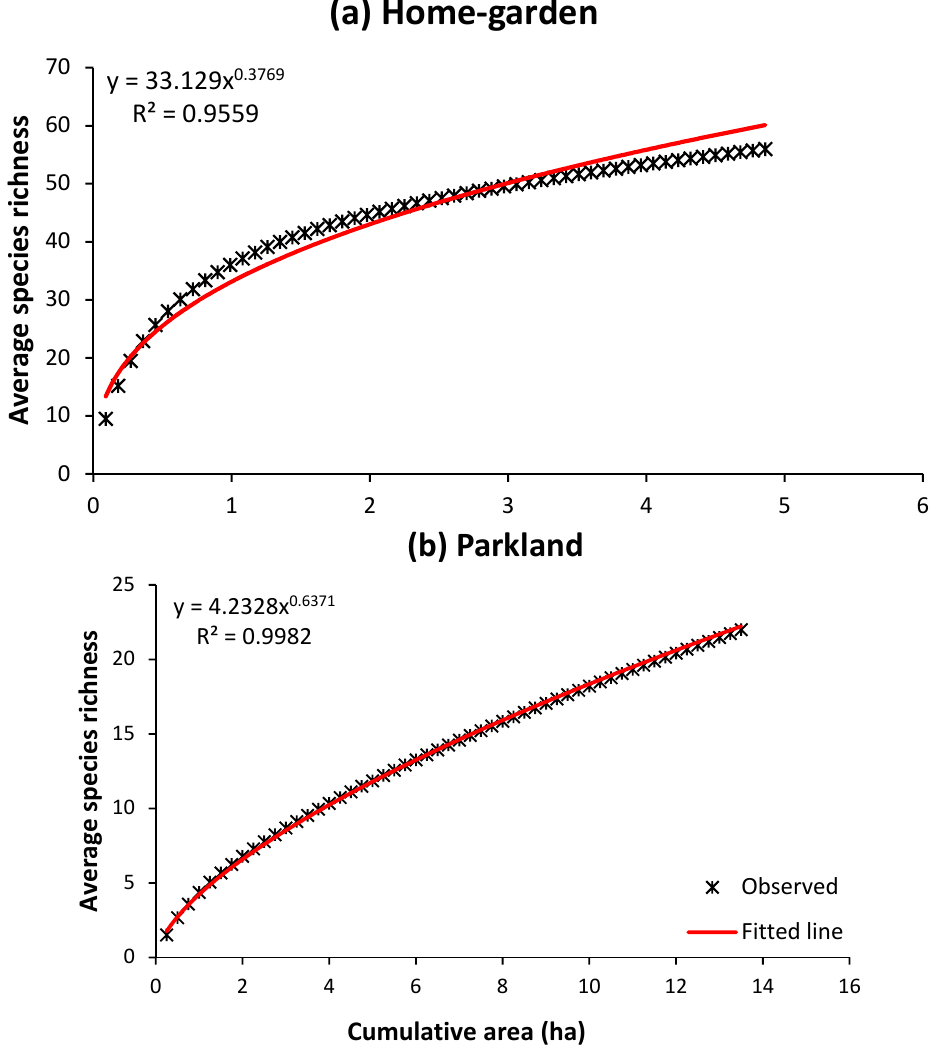
Figure 2. Species–area curves for ( a ) home gardens and ( b ) parkland agroforestry systems in Assosa district, western Ethiopia.